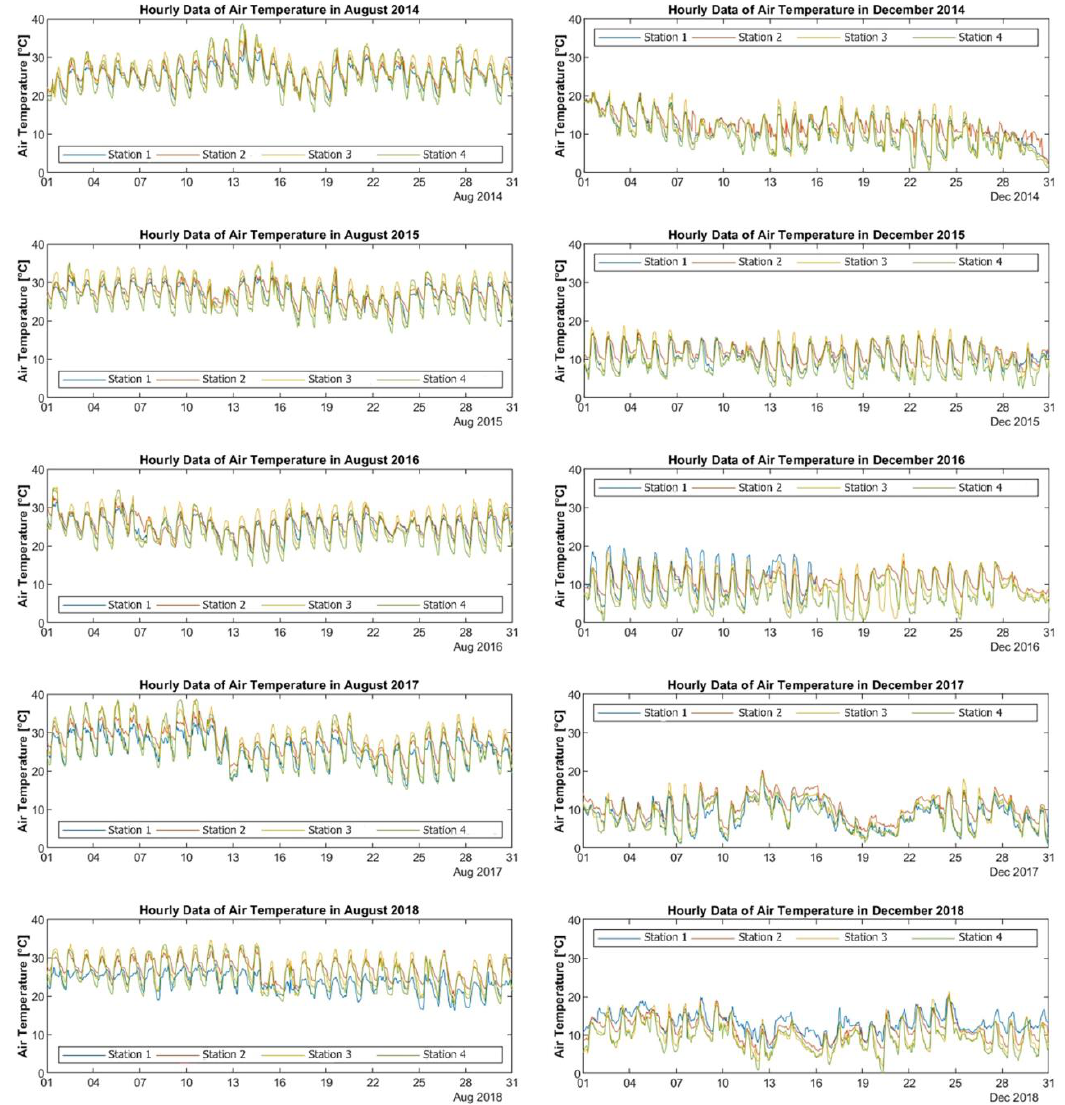
Figure 5. Hourly data of air temperature in August and December from 2014 to 2018. Blue hourly air temperature values for station 1, orange hourly air temperature values for station 2, yellow hourly air temperature values for station 3, green hourly air temperature values for station 4.